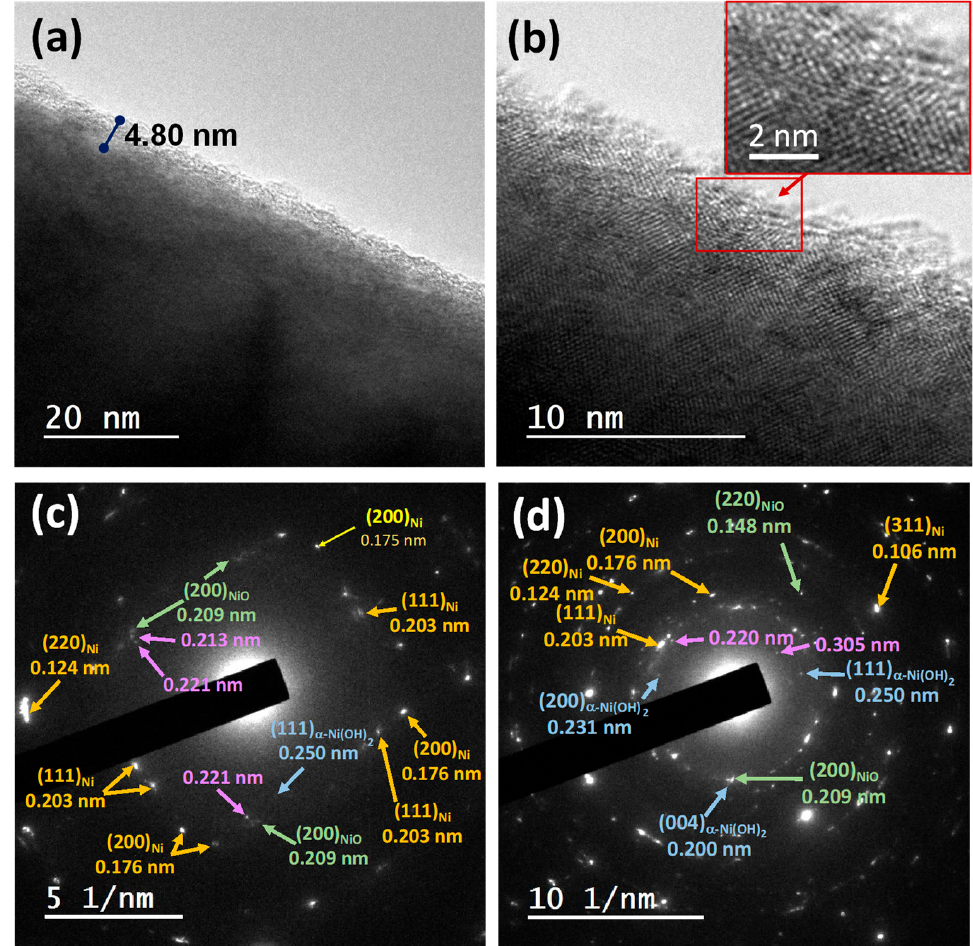
Figure 3. TEM and SAED studies of surface-treated Ni nanowires: ( a ) High-Magnification TEM image. ( b ) High-Resolution TEM image. ( c , d ) SAED patterns of different regions of the same nanowire.